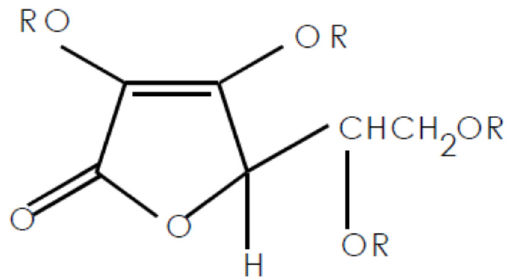
Figure 1. Chemical structure of VC-IP, in which R is an isopalmitate group.